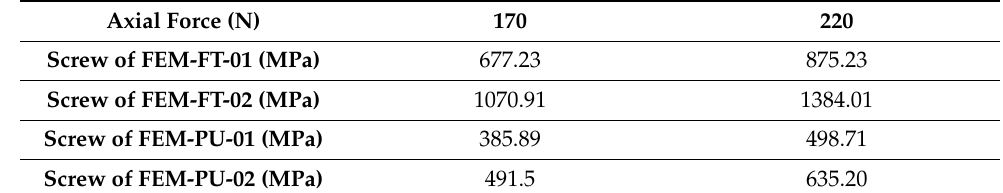
Table 4. Maximum von Mises stress on pedicle screws.